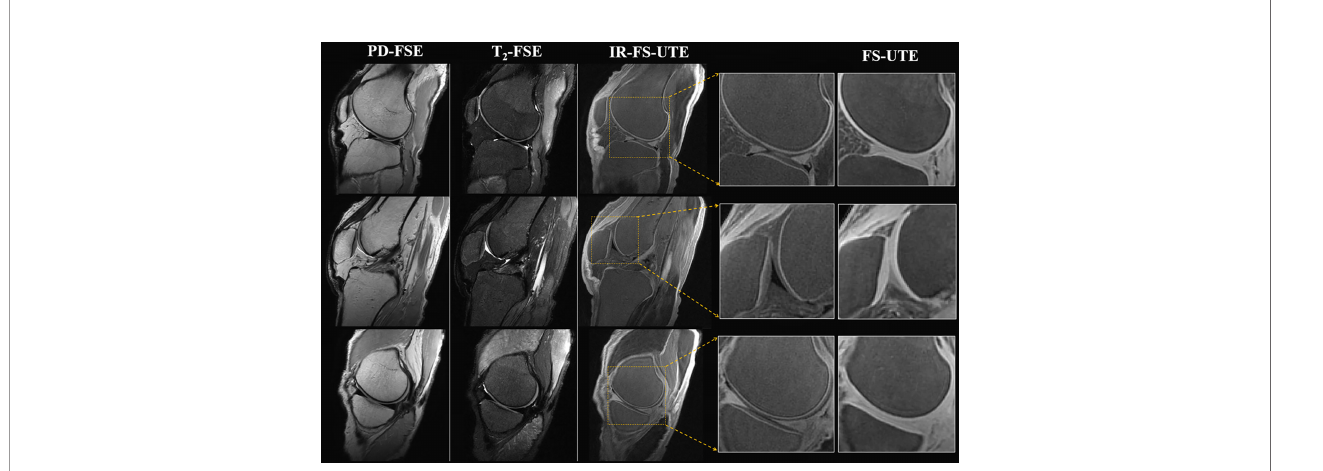
FIGURE 9 | Image of the OCJ region in a normal ex vivo knee joint sample from a 31-year-old male donor. The clinical images (PD-weighted FSE in fi rst column and T 2 -weighted FSE in second column) are employed to compare with the T 1 -weighted IR-UTE-Cones images (third column). High OCJ contrasts (i.e., bright band) are demonstrated in the IR-UTE-Cones images, which are more visible in the zoomed images. The last column consists of the conventional fat-saturated UTE-Cones images for the purpose of comparison. These demonstrate signal from both calci fi ed and uncalci fi ed cartilage. Modi fi ed, with permission from Ref (12).